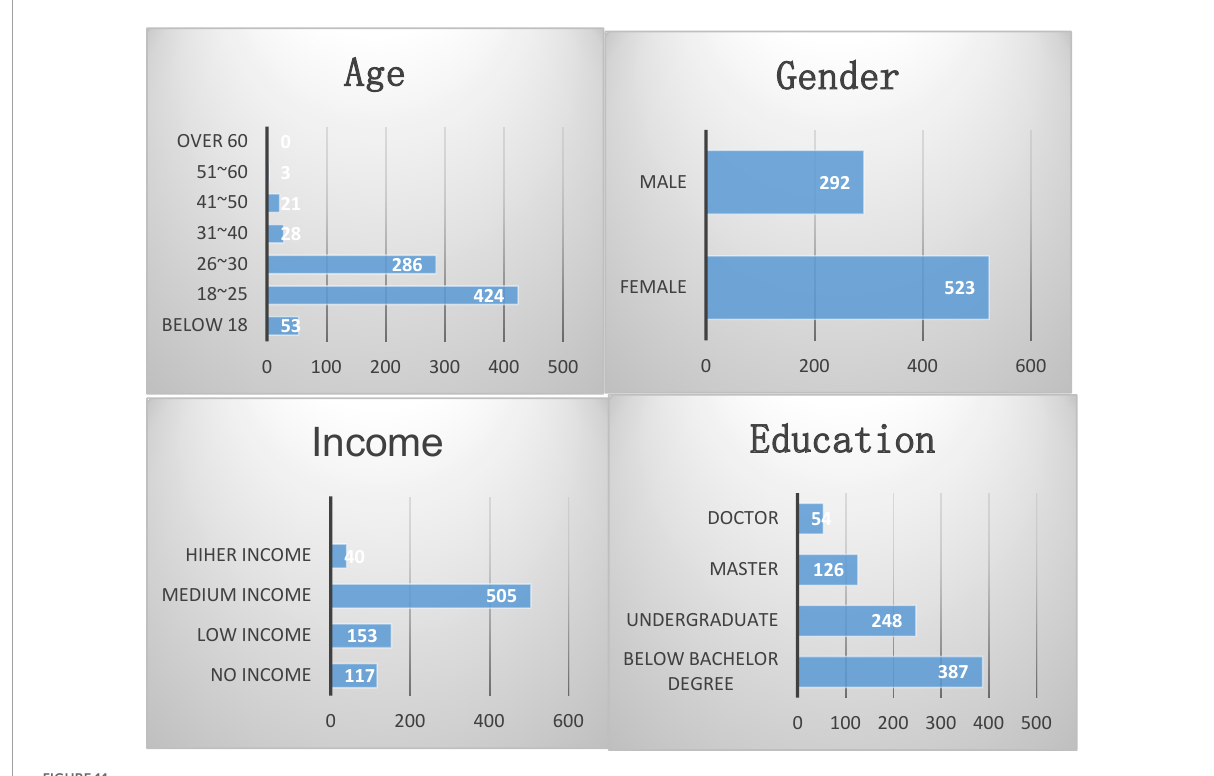
FIGURE11 Basic information of respondents.